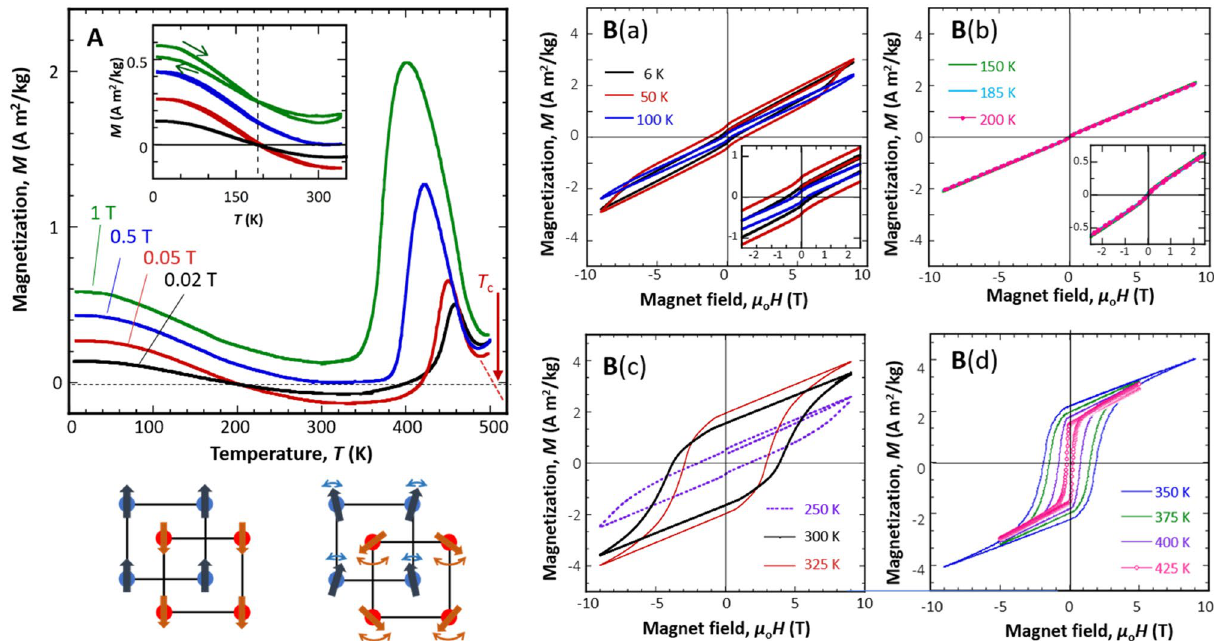
Figure 3. Magnetic properties. ( A ) Thermomagnetisation ( M – T ) curves of the (CrFe)S sample measured at 0.02 T, 0.05 T, 0.5 T, and 1 T in heating process (ZFC), together with magnetic field cooled (FC) M-T curves in the inset. Schematics of the magnetic state of the sublattices are illustrated in the bottom of ( A ). The magnetic moments in each sublattice were similar, but the strength of the exchange interaction depends on the magnetic- field and/or temperature. ( B ) Magnetisation ( M – H ) curves at different temperatures. (B(a)) 6–100 K: small hysteresis in the full loop; (B(b)) 150–200 K: perfectly linear relationship, indicating a fully compensated ferrimagnetic state; (B(c)) 250–325 K: abrupt hard-type magnetisation behaviour; and (B(d)) 350–425 K: magnetic coercivity ( H c ) gradually decreases with increasing